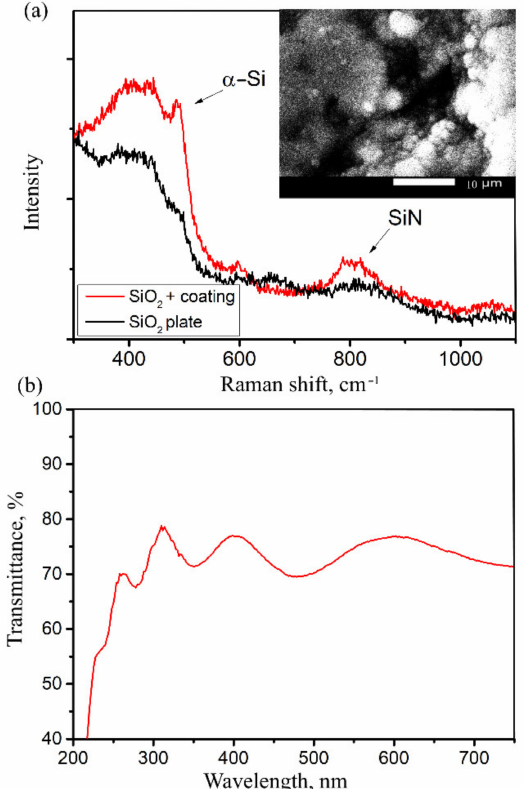
Figure 3. Characterization of silica plates with deposited silicon oxynitride: ( a ) Raman spectrum with SEM − image of the surface (inset), ( b ) transmission